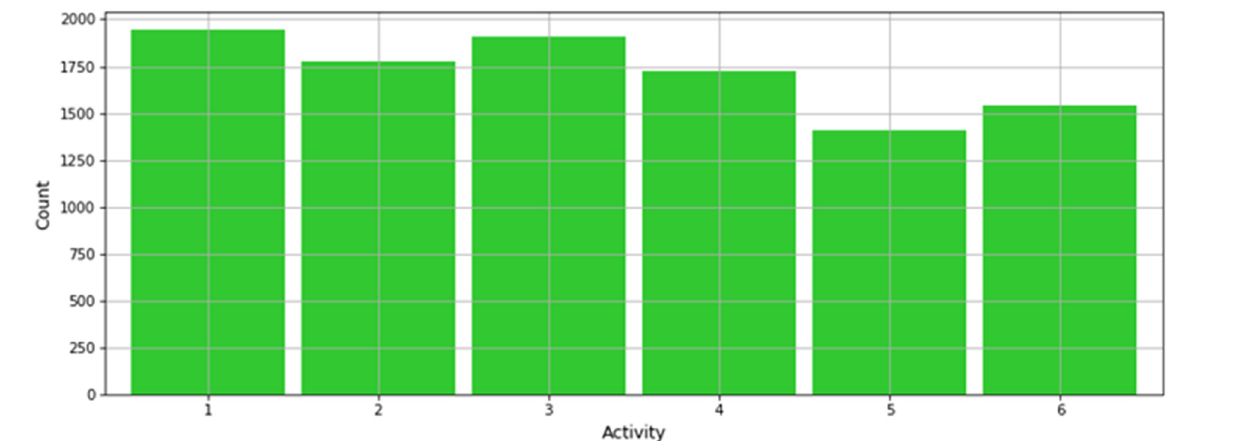
Figure 5. Low class skewness for the Human Activity Detection dataset.